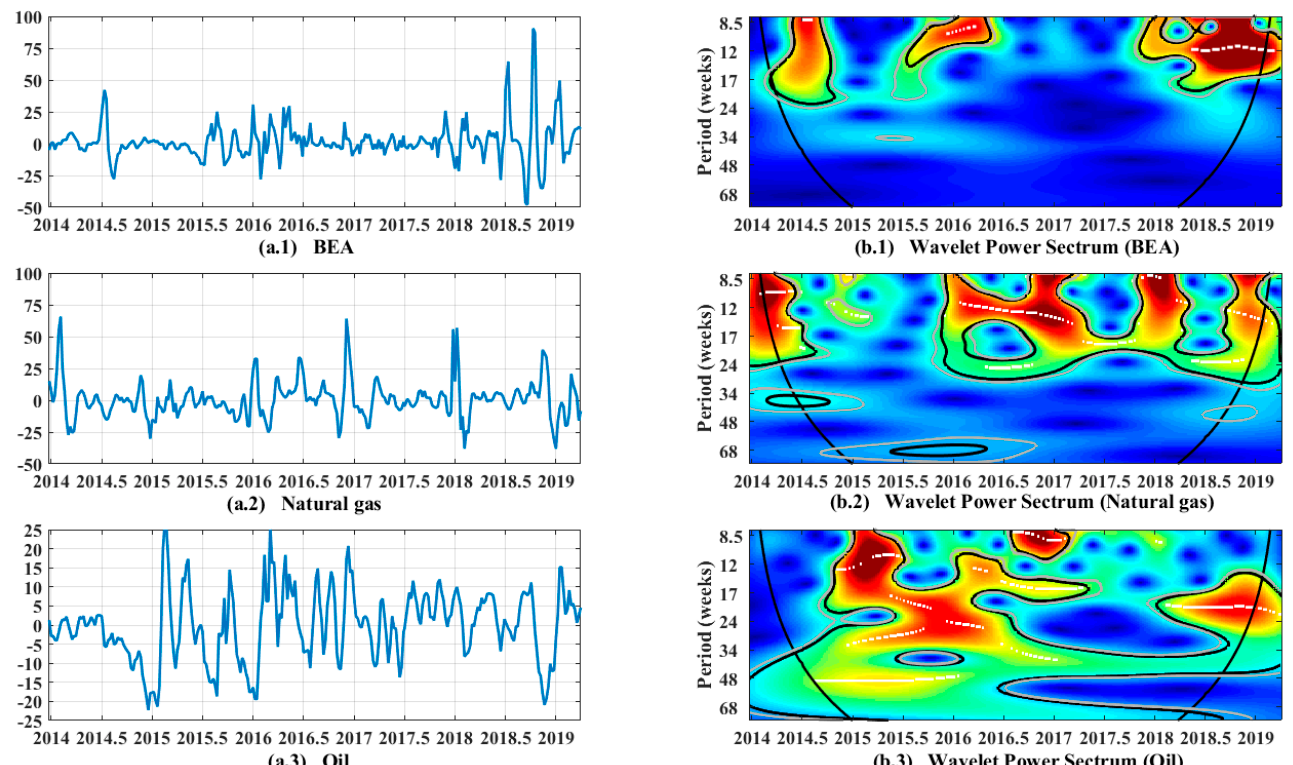
Figure 1. Monthly rate of return and self-wavelet power spectrum. Note: ( a.1 – a.3 ) indicates monthly return chart for each time series, and ( b.1 – b.3 ) shows self-wavelet power spectrum. When the wavelet power spectrum is expressed as the coherency of two time series in the time and frequency domains, it is called cross-wavelet power spectrum and defined (cid:12) (cid:12) (cid:12) (cid:12) 2 2 = | W ( τ , s ) | 2 as . Similarly, the strength of the coherency between (cid:12) W xy ( τ , s ) (cid:12) (cid:12) (cid:12) W y ( τ , s ) x the two time series can be indicated by the warm and cool colours in the cross-wavelet power spectrum. The blue part corresponds to the low-power region, indicating that the correlation of two time series is low at this time and frequency domain. The red part represents the high-power region, indicating that the coherency of two time series is high at this time and frequency